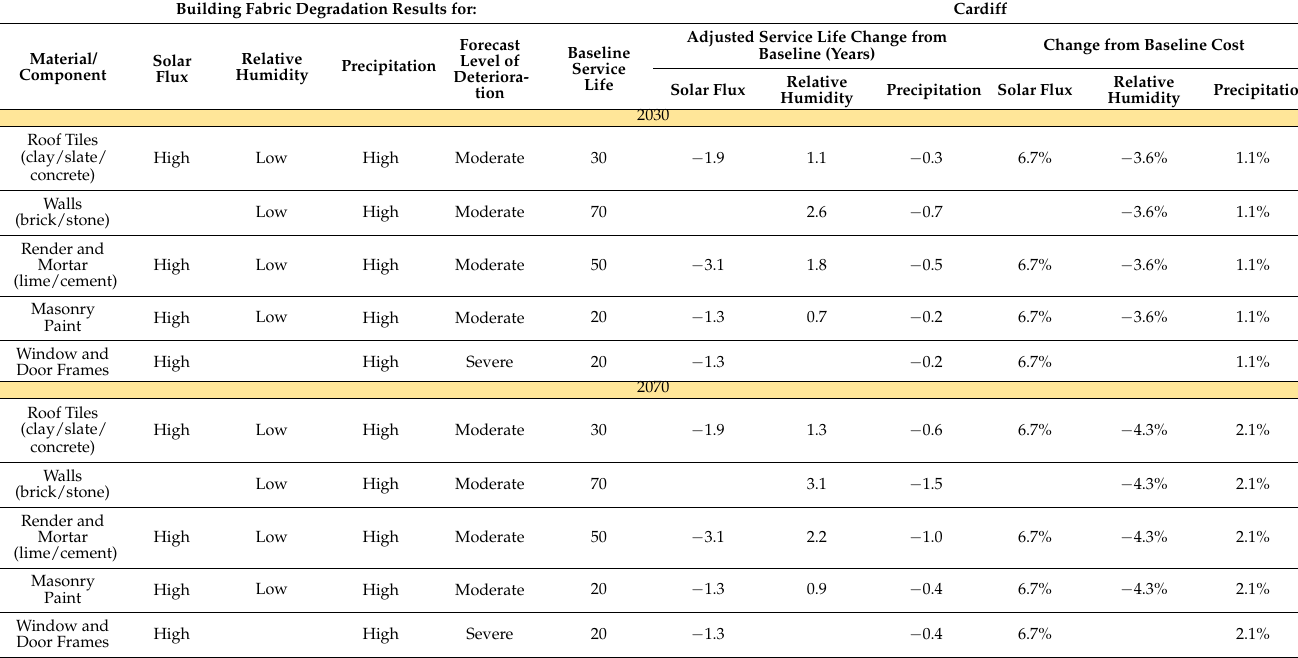
Table 2. Results for building-fabric degradation analysis for Cardiff showing deterioration classifica- tion, adjusted service life, and change in cost for 2030 and